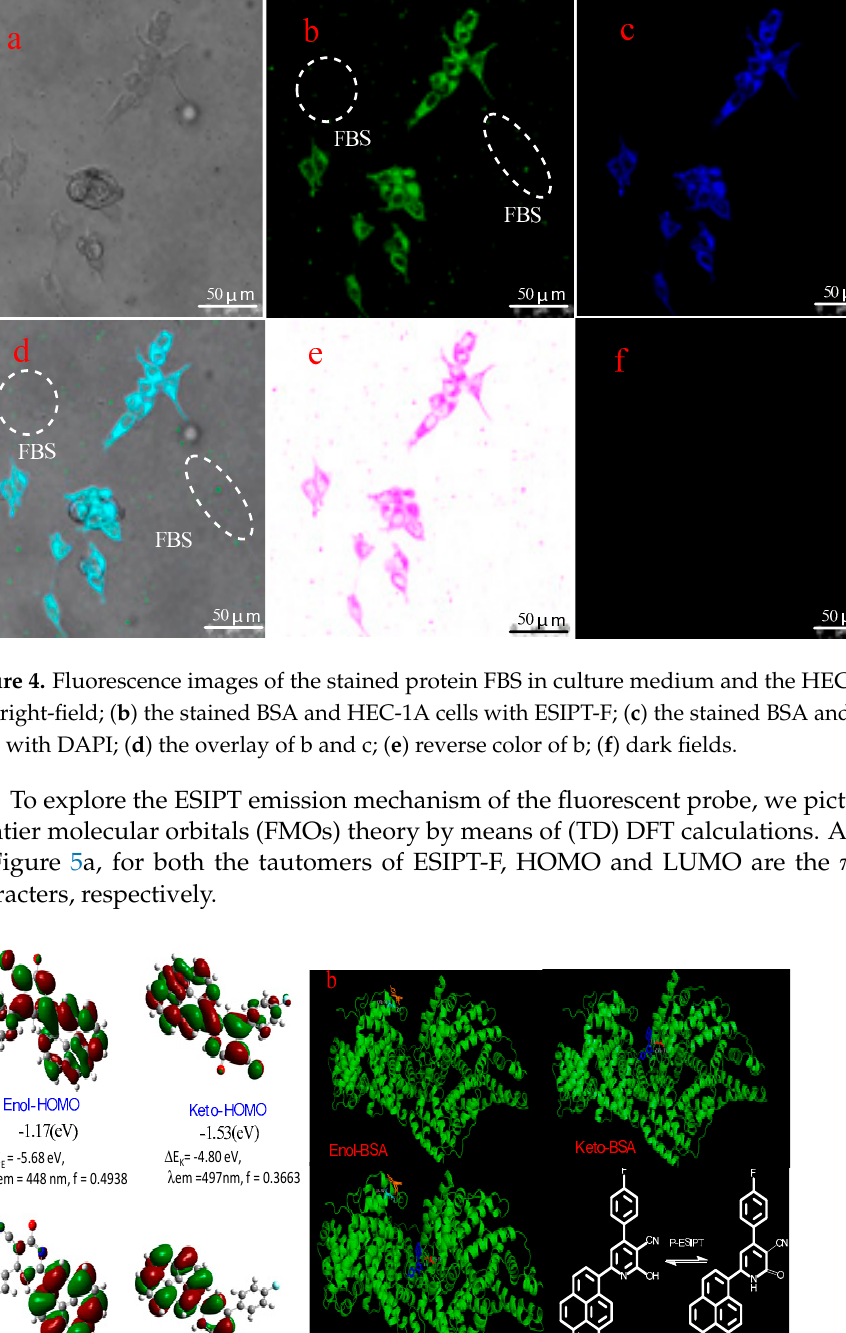
Figure 5. ( a ) Frontier molecular orbitals (HOMO and LUMO) of ESIPT-F obtained at B3LYP/6- 31++G** level of calculation; ( b ) Molecular docking calculations of ESIPT-F to BSA were based on Auto dock-vina (2010).